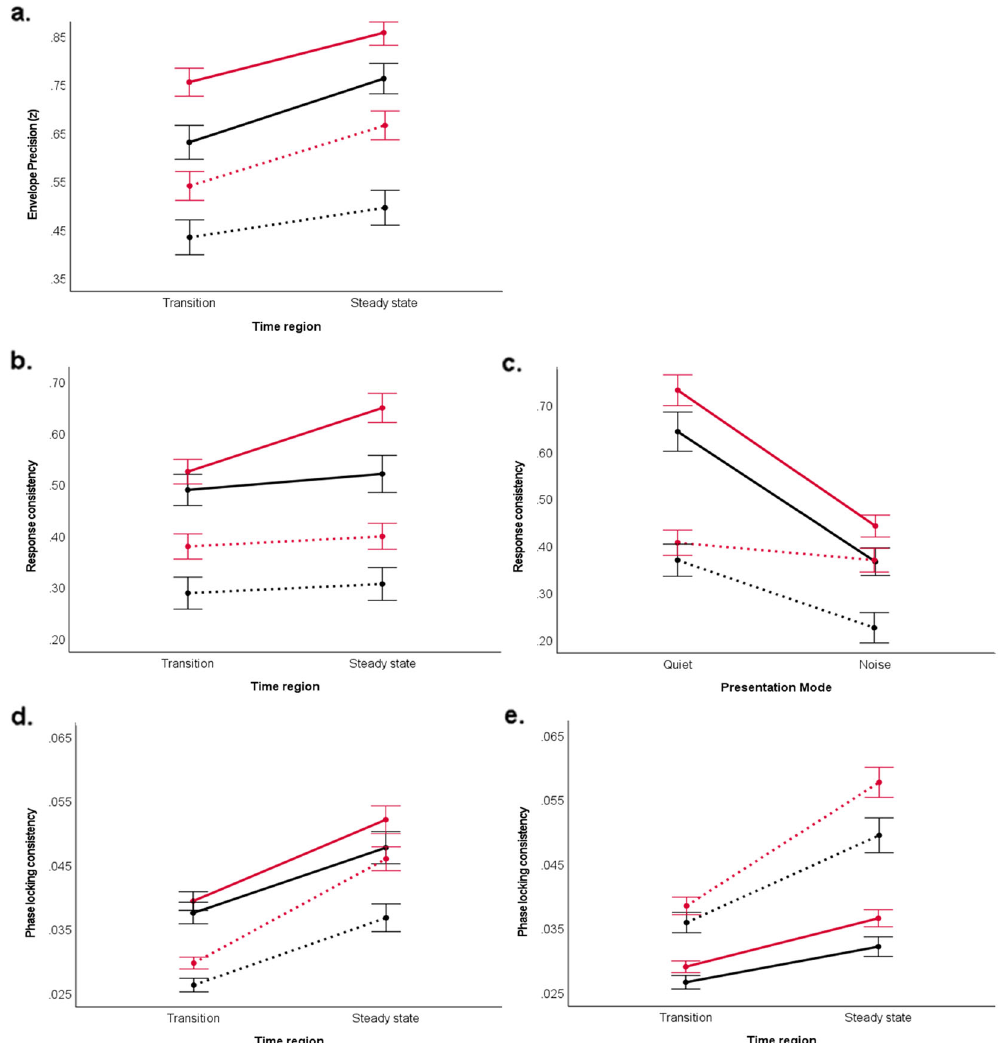
Fig. 3 Interaction between presentation mode, time region of the FFR, frequency, and synchronization ability group (Non-synchronizer: black, Synchronizer: red) in determining envelope-encoding precision, response consistency, and phase-locking consistency. A repeated- measures ANOVA was used to evaluate the effects of the between-group variable (synchronization ability group) with the within-group variables considered. Signi fi cant interaction effects are represented. ( a ) As for envelope-encoding precision, a signi fi cant interaction was found between all three factors-presentation mode (Quiet: solid line; Noise: dotted line) x time region x synchronization group ( F = 4.314, p = 0.012, η p 2 = 0.071). As for response consistency, the following signi fi cant interactions are represented: ( b ) polarity (Added: solid line; Subtracted: dotted line), time region, and synchronization group ( p < 0.01). ( c ) Presentation mode, polarity (Added: solid line; Subtracted: dotted line), and synchronization group ( p < 0.01). As for phase-locking consistency, the following signi fi cant interactions are represented: ( d ) time region of the FFR, presentation mode (Quiet: solid line; Noise: dotted line), and synchronization group ( p < 0.05), and ( e ) an interaction between time region of the FFR, frequency (Low: solid line; High: dotted line), and synchronization group ( p < 0.05). For all graphs, Non- synchronizer means are shown by the black lines and Synchronizer means are the red lines. Means for the FFR measure considered are displayed on the y -axis. Error bars represent ± 1 standard